Question: Author a descriptive caption for the visualization shown.
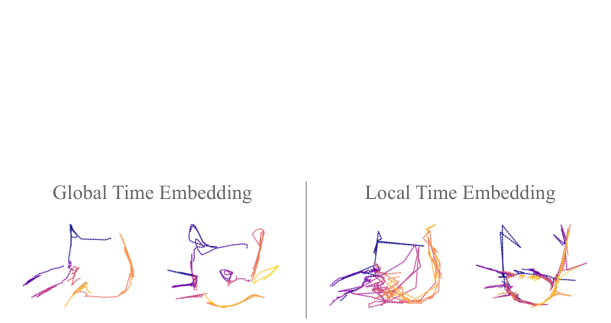
Answer: Global vs Local time embedding: Global embedding gives smooth sketches compared to local, which gives jittering.